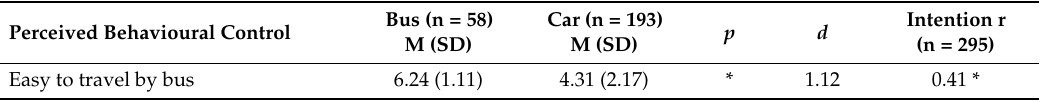
Table 8. Perceived behavioural control for a journey by bus. Mean, SDs, Cohen’s d for either bus users or car drivers and Pearson’s correlation with intention.